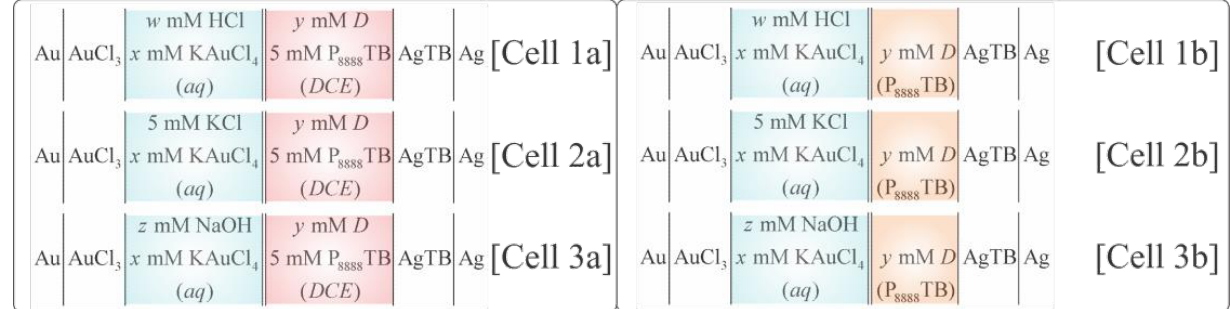
Figure 2. Cyclic voltammograms (CVs) measured using Cells 1a – 3a ( A – C ) with no electron donor added to the DCE phase. 1 mM of KAuCl 4 was dissolved in the aqueous phase with the pH = 2, 5.5 – 6, and 8.5 for the top, middle, and bottom panels, respectively. A 25 µm diameter ITIES was used with a scan rate of 0.020 V s – 1 . The red arrow indicates the axes plotted against, black arrows indicate scan direction, and the peak currents have been labelled with the associated simple ion transfer process taking place.